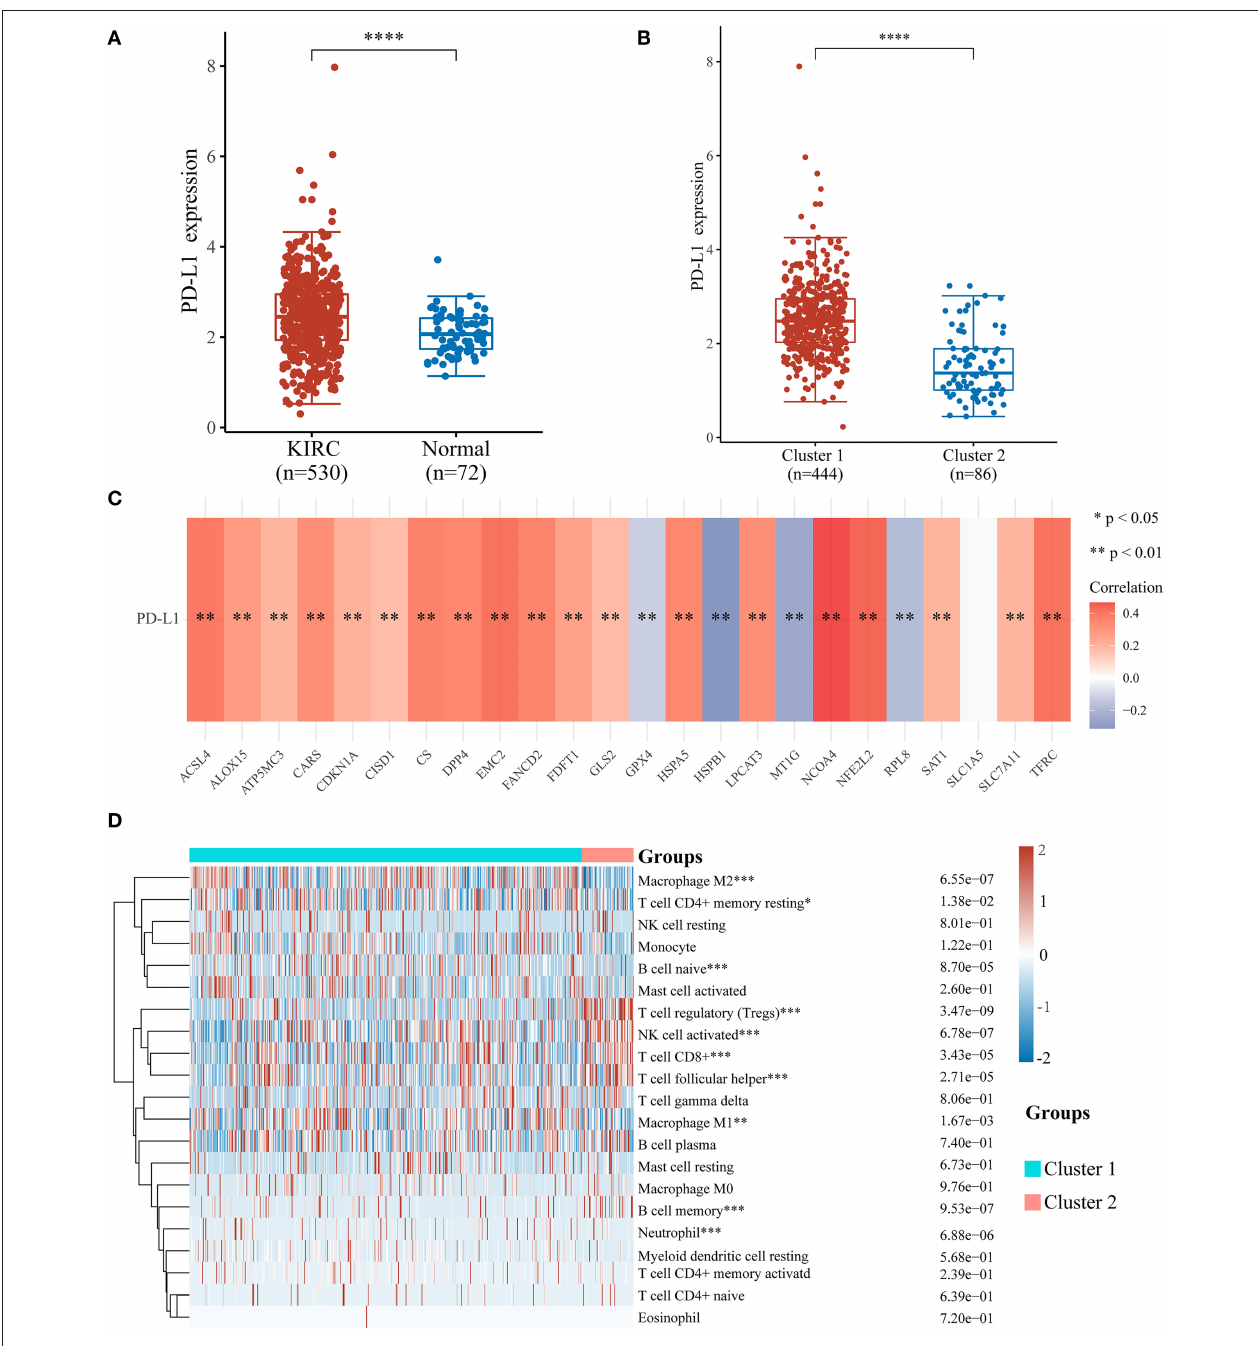
FIGURE 3 | Association of PD-L1 with ferroptosis regulators and the differential infiltration level of tumor immune cells in two clear cell renal cell carcinoma (ccRCC) subtypes. (A,B) The expression level of PD-L1 in ccRCC/normal group (A) and cluster 1/2 subtype (B) in ccRCC. (C) The correlation of PD-L1 with ferroptosis regulators in the TCGA-KIRC cohort. (D) The infiltrating levels of various immune cell types in two subtypes in the TCGA-KIRC cohort. * p < 0.05, ** p < 0.01, *** p < 0.001, and **** p <